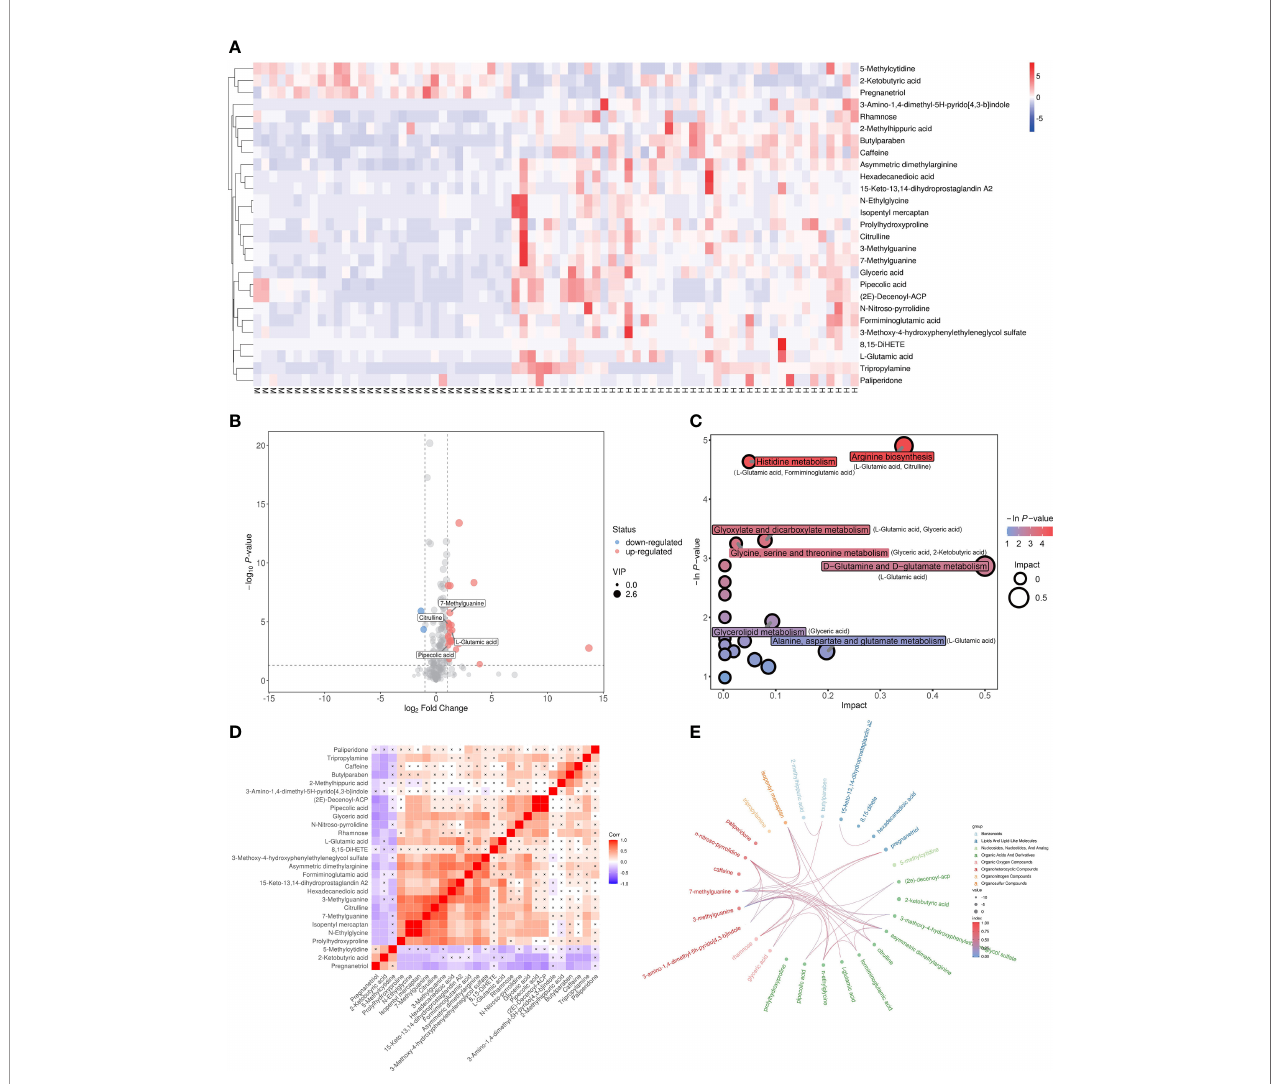
FIGURE 2 | Dysregulated metabolites between MetS and MetS(+) HCC patients identi fi ed in metabolic pro fi ling. (A) Hierarchical clustering showing the dysregulated metabolites between MetS and MetS(+) HCC patients. Each column represents a sample, and each row represents a metabolite. M represents MetS individual, and H represents MetS(+) HCC patient. ‘ Red ’ indicates a high level, and ‘ blue ’ indicates a low level. (B) The volcano plot depicts the difference of metabolites between MetS and MetS(+) HCC patients. Red points (up-regulated) and blue points(down-regulated) refer to signi fi cant dysregulation according to fold change > 2.0 and p value < 0.05. (C) Pathway enrichment analysis of differential metabolites identi fi ed in MetS(+) HCC versus MetS group. (D) Correlation analysis of differential metabolites identi fi ed in MetS(+) HCC versus MetS group. ‘ Red ’ indicates a positive correlation, and ‘ blue ’ indicates a negative correlation. (E) Chord plot analysis of differential metabolites identi fi ed in MetS(+) HCC versus MetS